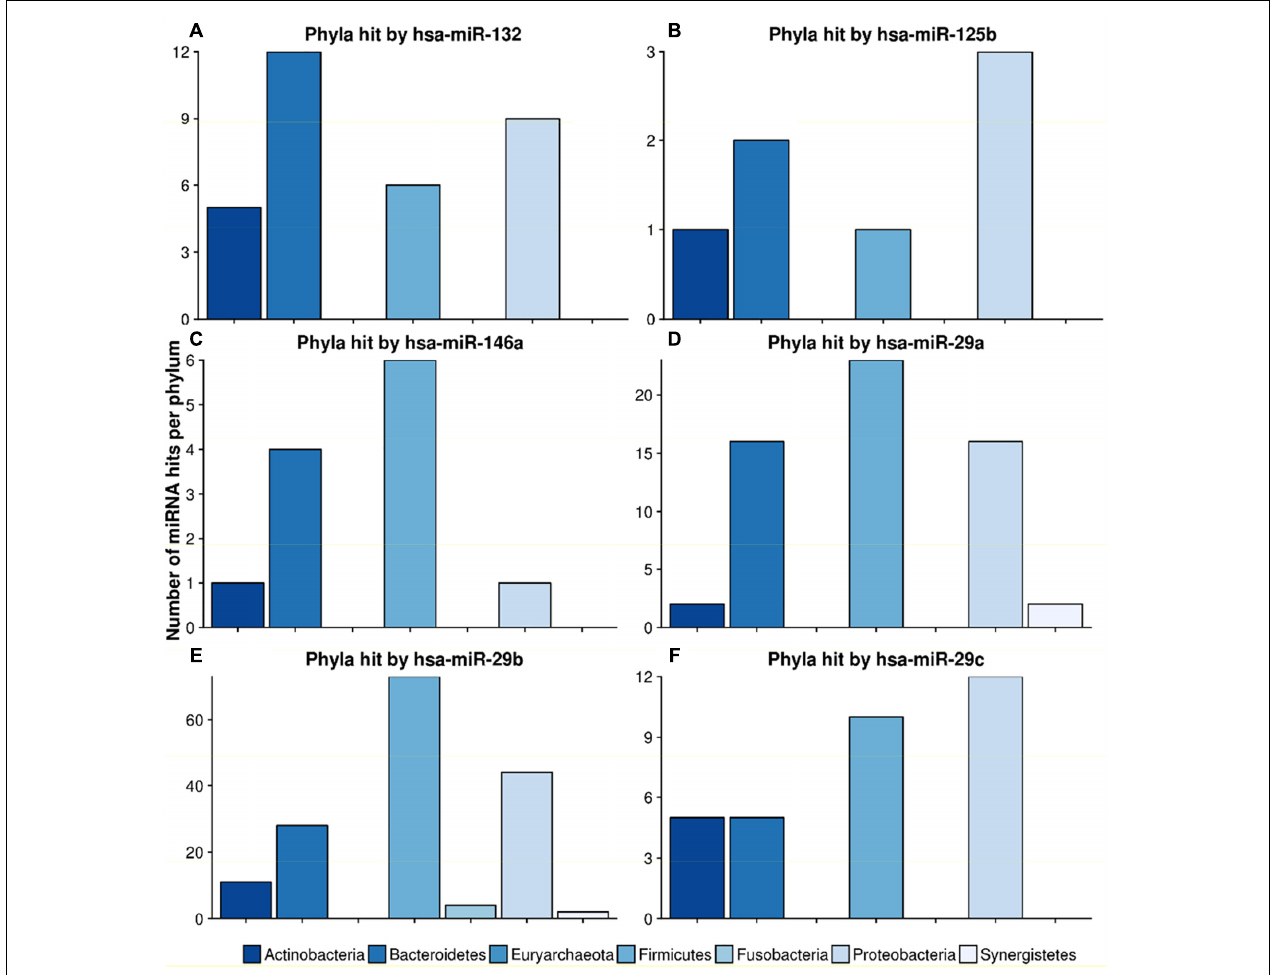
FIGURE 7 | Number of hits from specific miRNAs per phylum. The bar plots show the number of hits from miRNAs (A) hsa-miR-132, (B) hsa-miR-125b, (C) hsa-miR-146a, (D) hsa-miR-29a, (E) hsa-miR-29b and (F) hsa-miR-29c counted for different phyla. The legend can be found at the bottom. The colors refer to different